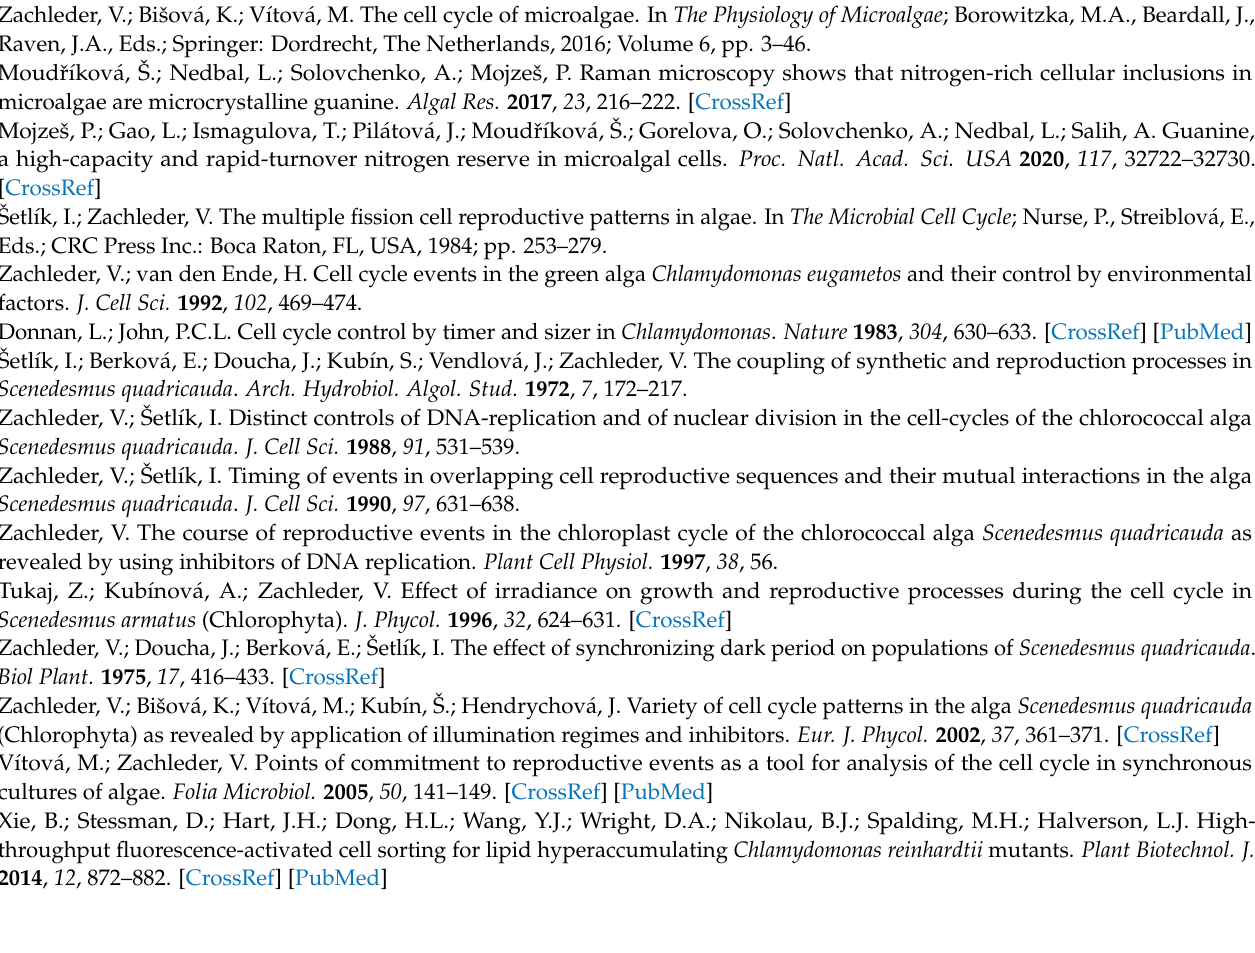
compared with the respective chemical references. Figure S4: Raman chemical maps of eight-cell coenobium of D. quadricauda and the spectral components obtained by a multivariate deconvolution. Figure S5: Raman chemical maps of the cells illustrating in detail the time course of changes in their molecular composition during the cell